Question: What style of plot is this figure drawn as?
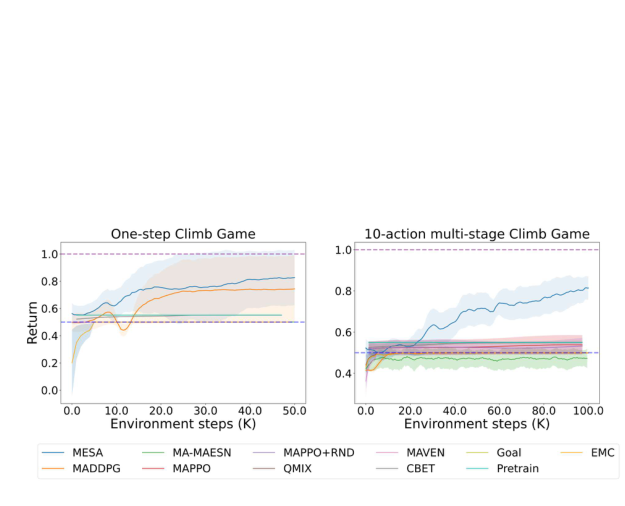
Answer: line